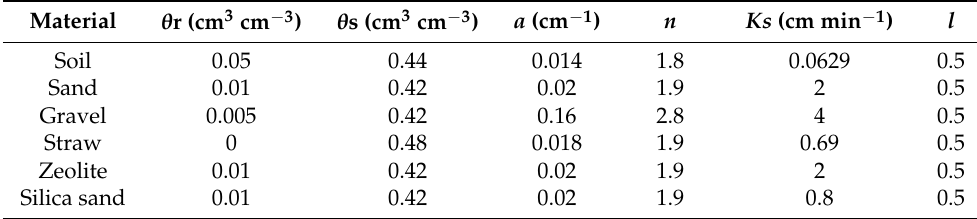
Table 2. VG model parameters of the soil and filters.